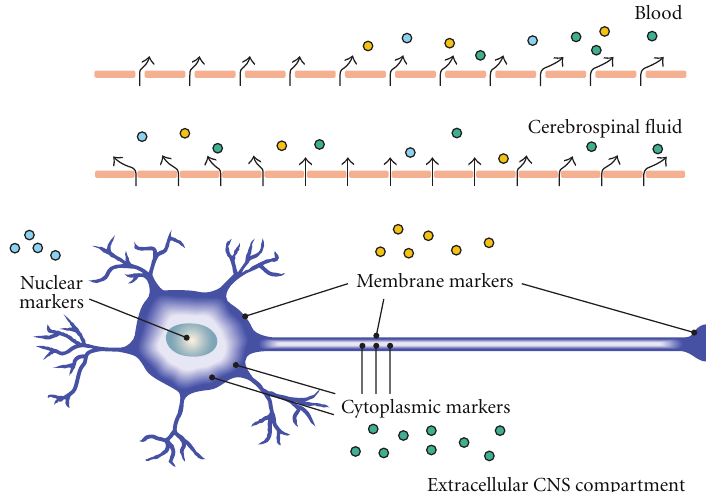
Figure 2: Membrane, cytoplasmic, and nuclear markers of neuroaxonal damage in the central nervous system (CNS) and their dynamics within three compartments (extracellular space, cerebrospinal fluid, and